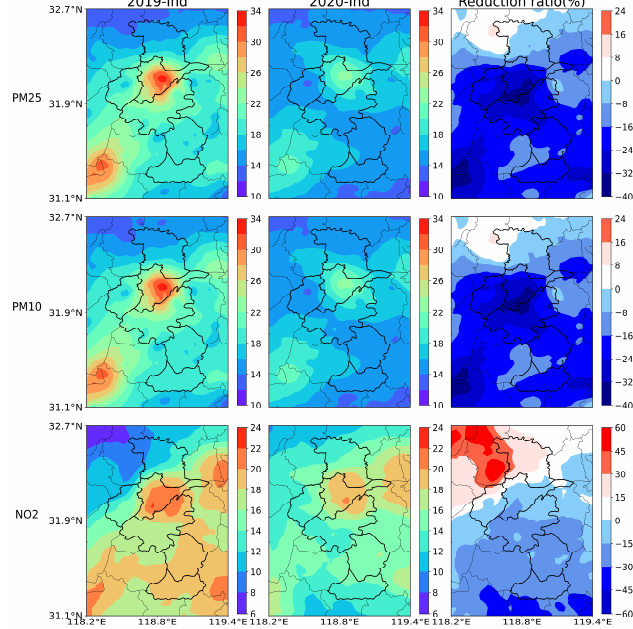
Figure 9. Spatial distribution of average NO 2 , PM 2.5 , and PM 10 concentrations ( µ g/m 3 ) from near- surface industrial emissions and the percentage reduction during the NP and LP in the Nanjing City model simulation